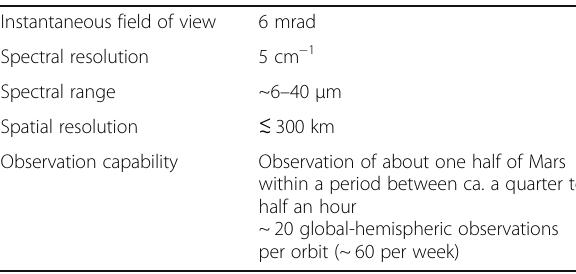
Table 1 Instrument specifications of EMIRS onboard EMM Instantaneous field of view